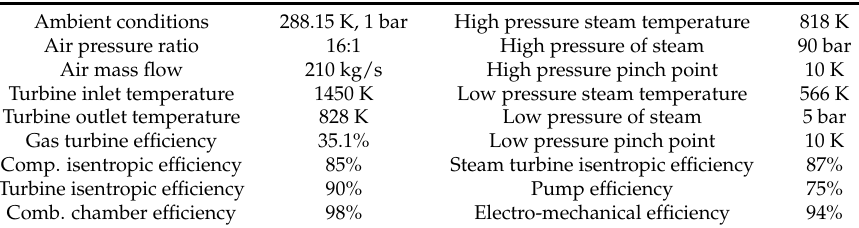
Table 1. Design parameters of the reference CCGT.